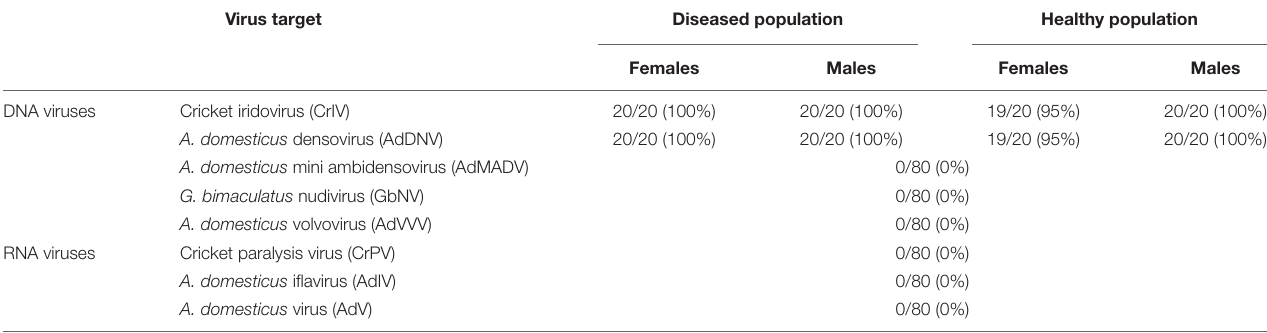
TABLE 2 | Prevalence of targeted viruses across two populations (“Healthy” and “Diseased”) of male and female adult reared Gryllodes sigillatus using qPCR. Virus target